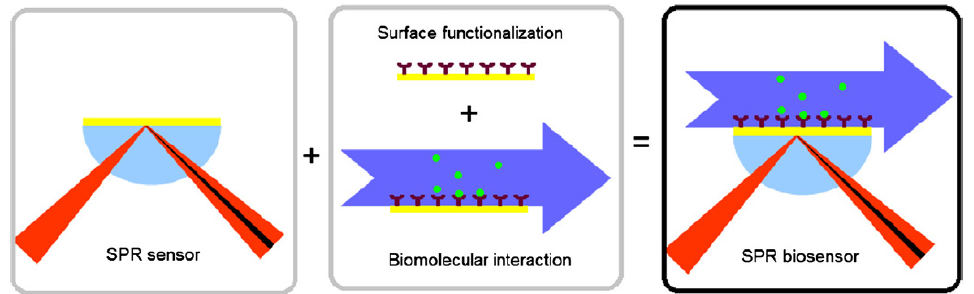
Figure 8. Principles of SPR biosensor illustration. Reprinted with permission from ref. [135]. Copyright 2011, Elsevier.